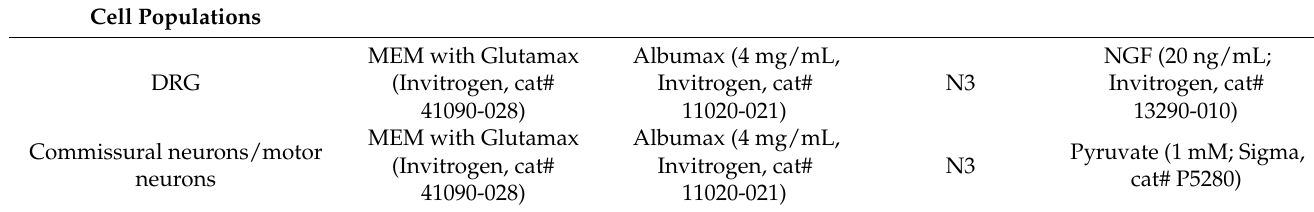
Table 4. Media contents for different cell populations in dissociated cell cultures and explants. Cell